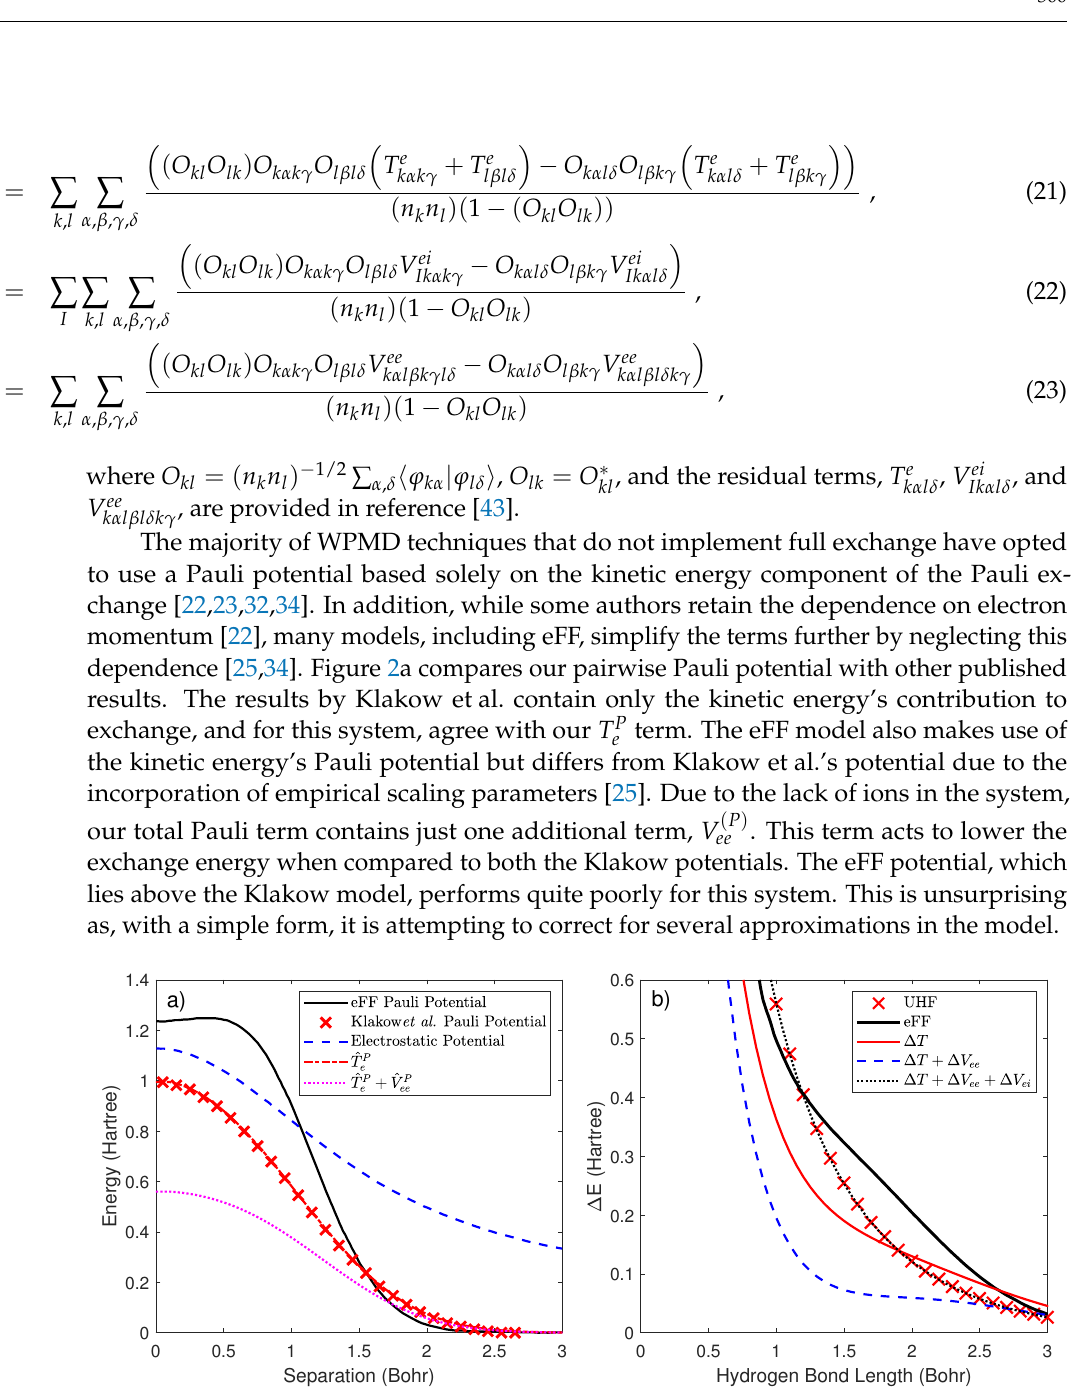
Figure 2. Validation of the three-term Pauli potential. ( a ) The Pauli potential consisting of all three energy terms is compared to the potential used in eFF and that developed by Klakow et al. which uses only the kinetic energy term [32]. Results are given for the exchange energy between two electrons of √ fixed-width σ = 3/4. Unlike the electrostatic energy, shown by the dashed line, the Pauli potentials do not exhibit long-ranged behavior. ( b ) Verification of the Pauli potential following the method suggested by Xiao et al. [45]. The different energy contributions upon anti-symmetrization for the triplet H 2 system. In this system, the unrestricted Hartree–Fock (UHF) result is exact. Each electron is represented by a single Gaussian of radius 1.7 Bohr centered on the atom. Note, the eFF potential does not match the exact UHF